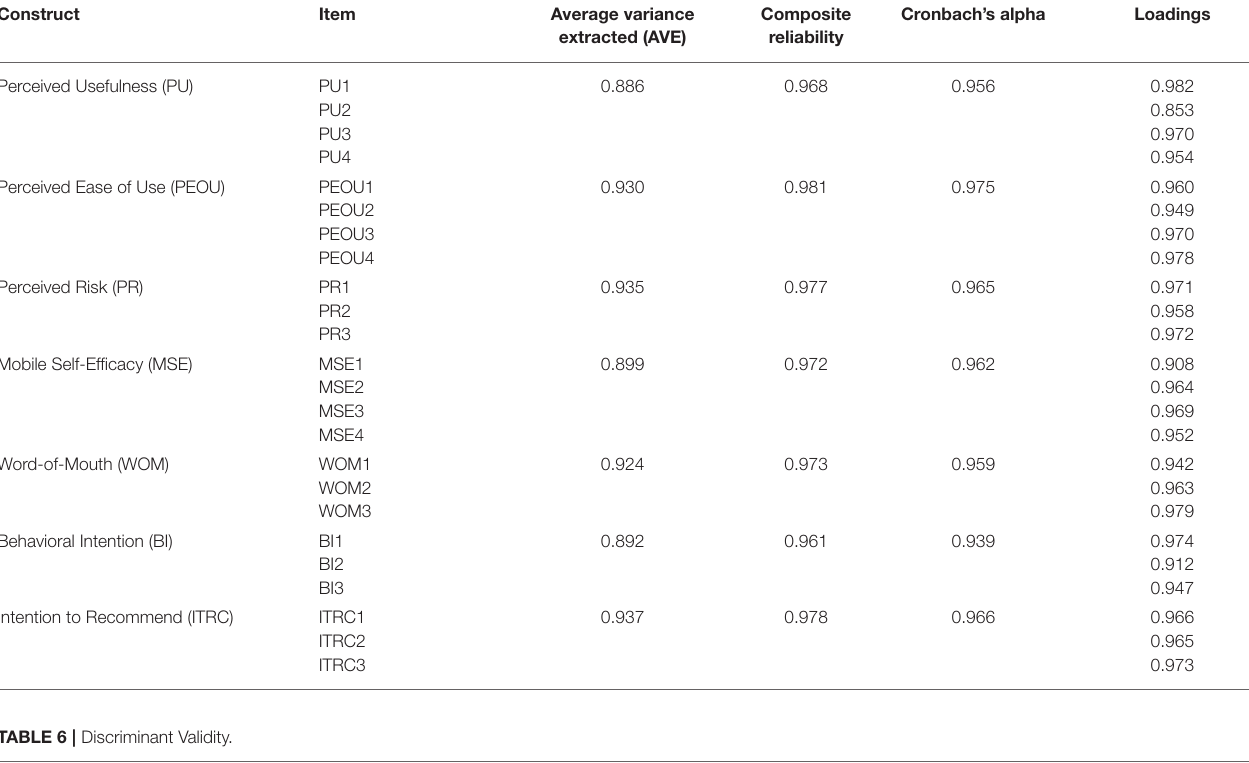
TABLE 5 | Quality criterion (AVE, composite reliability, alpha) and factor loadings.